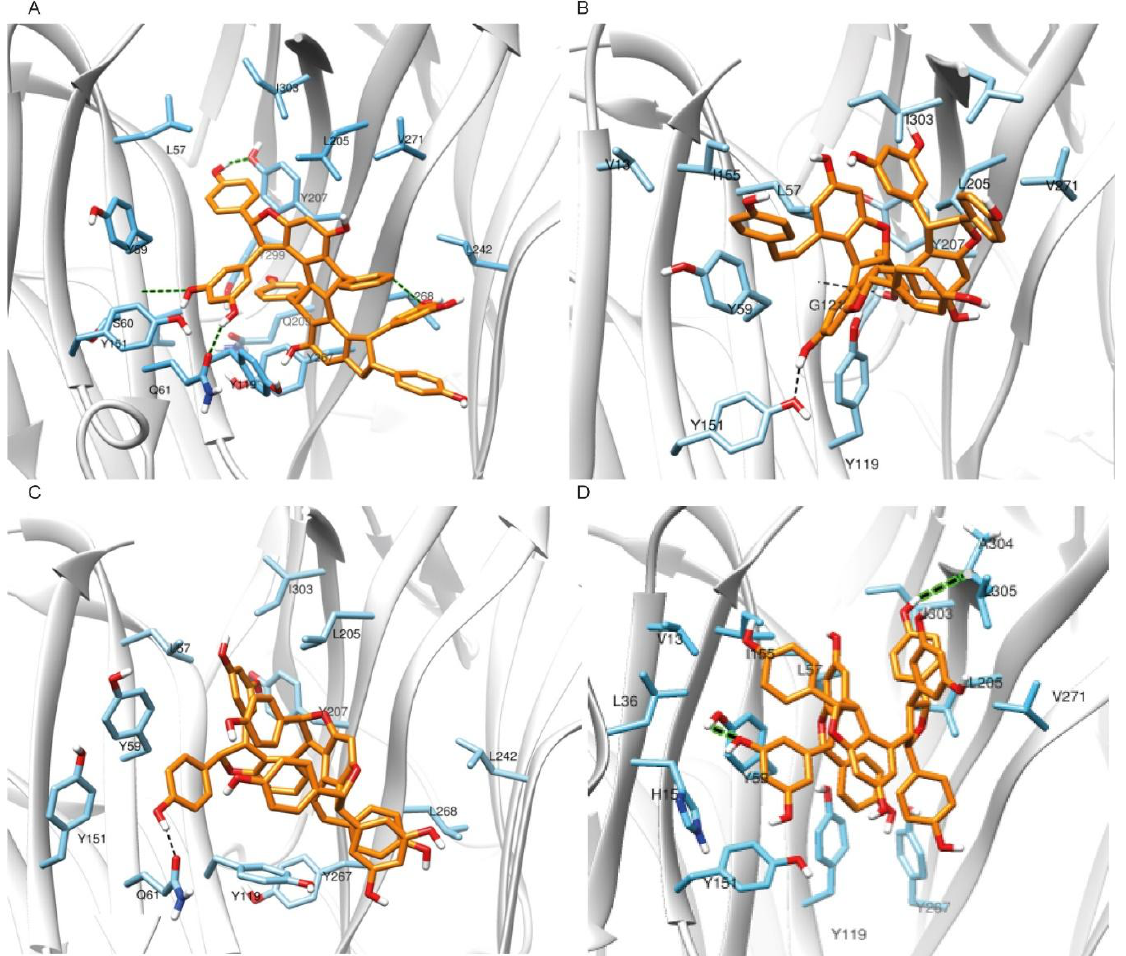
Figure 6. Main interactions between the compounds and the TNF binding cavity residues after 1000 ns MD simulation. Schematic representation of ( A ) Nepalensinol B; ( B ) Miyabenol A; ( C ) Flexuosol A and ( D ) Kobophenol A, when bound to the TNF cavity. Average conformations of the ligands within the cavity, along with protein residues that are involved in hydrogen bond interactions with the compounds are shown with black dashed lines, and green dashed for further clarification.